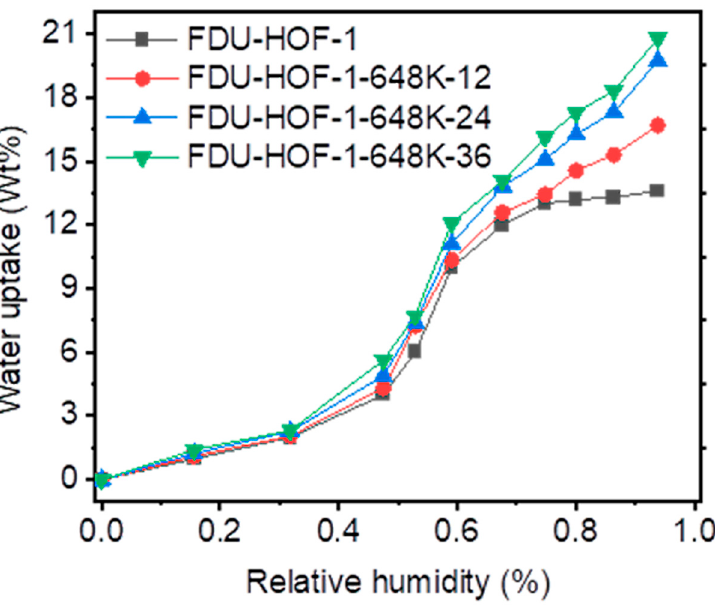
Figure 5. Water vapor uptake of FDU-HOF-1 (black), FDU-HOF-1-648 K-12 h (red), FDU-HOF-1-648 K-24 h (blue), and FDU-HOF-1-648 K-36 h (green).